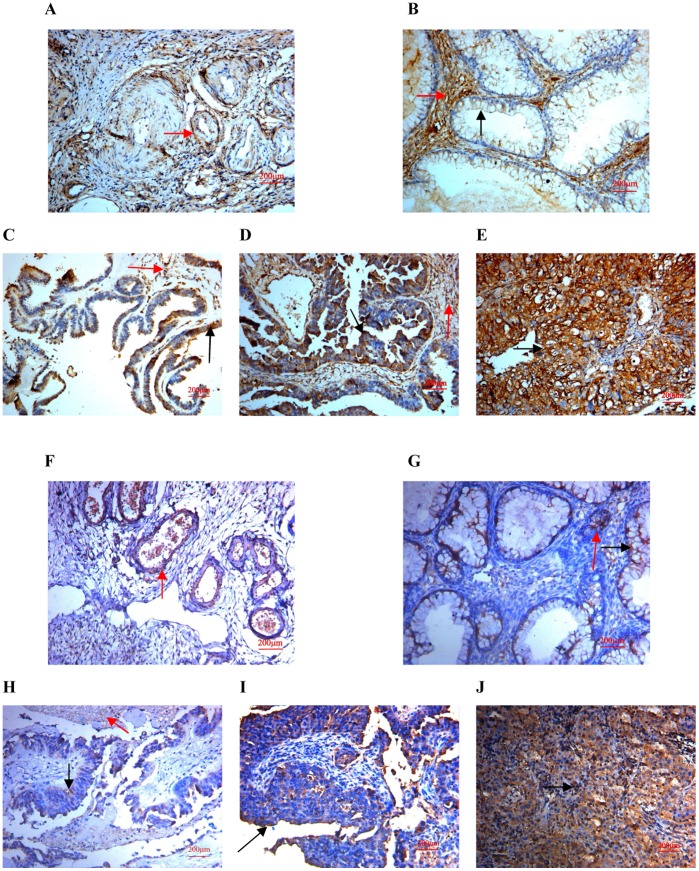
Expression of SPARC in human ovarian tissues using antibody AF941 and bs-1133R.(A) Normal human ovarian tissue using antibody AF941, (B) Benign ovarian tumor using antibody AF941, (C) High differentiation of ovarian carcinoma using antibody AF941, (D) Medium differentiation of ovarian carcinoma using antibody AF941, (E) Low differentiation of ovarian carcinoma using antibody AF941, (F) Normal human ovarian tissue using antibody bs-1133R, (G) Benign ovarian tumor using antibody bs-1133R, (H) High differentiation of ovarian carcinoma using antibody bs-1133R, (I) Medium differentiation of ovarian carcinoma using antibody bs-1133R, (J) Low differentiation of ovarian carcinoma using antibody bs-1133R (Magnification ×200). Black arrows indicate cell cytoplasm stained, red arrows indicate stroma stained.